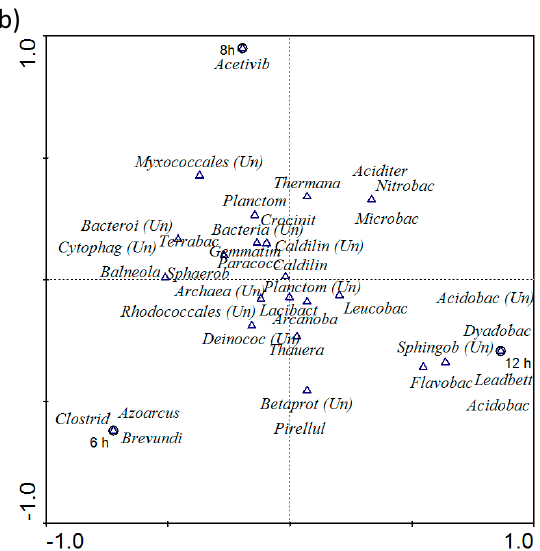
Figure 5. CCA (canonical correspondence analysis) graph showing the effect of cycle length on the composition of microorganisms at the phylum ( a ) and genus ( b ) level; abbreviations: